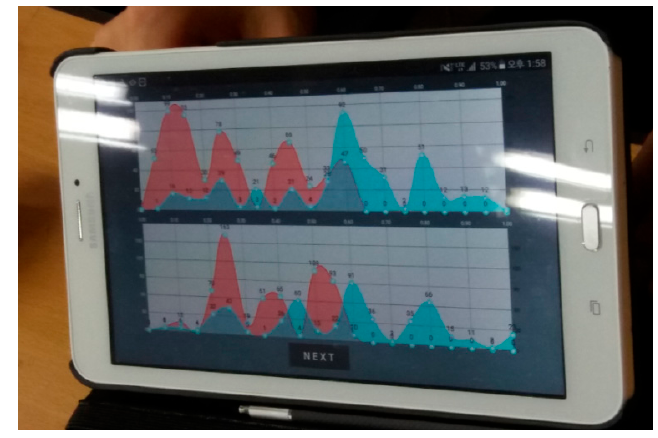
Figure 9. Design and test bed of Signature displacement comparison graph.